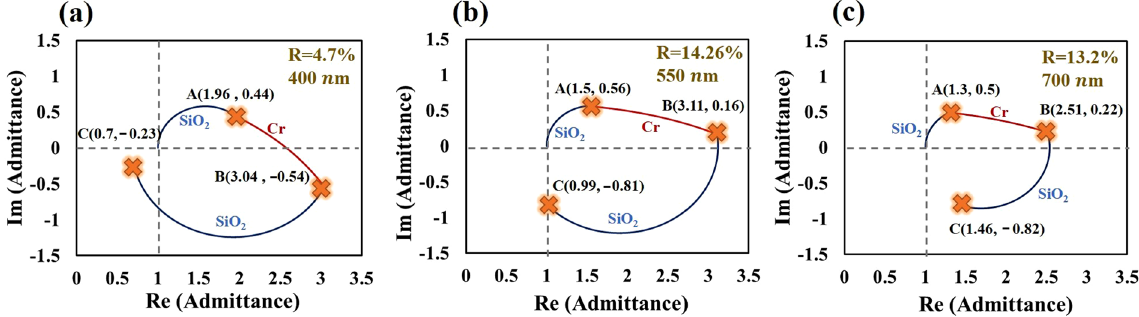
Figure 2. NAD loci of Air/SiO 2 (55 nm)/Cr(6 nm)/SiO 2 (55 nm)/Air system, at wavelengths of 400 nm, 550 nm, and 700 nm, shown as blue (SiO 2 ), and red (Cr) curves.